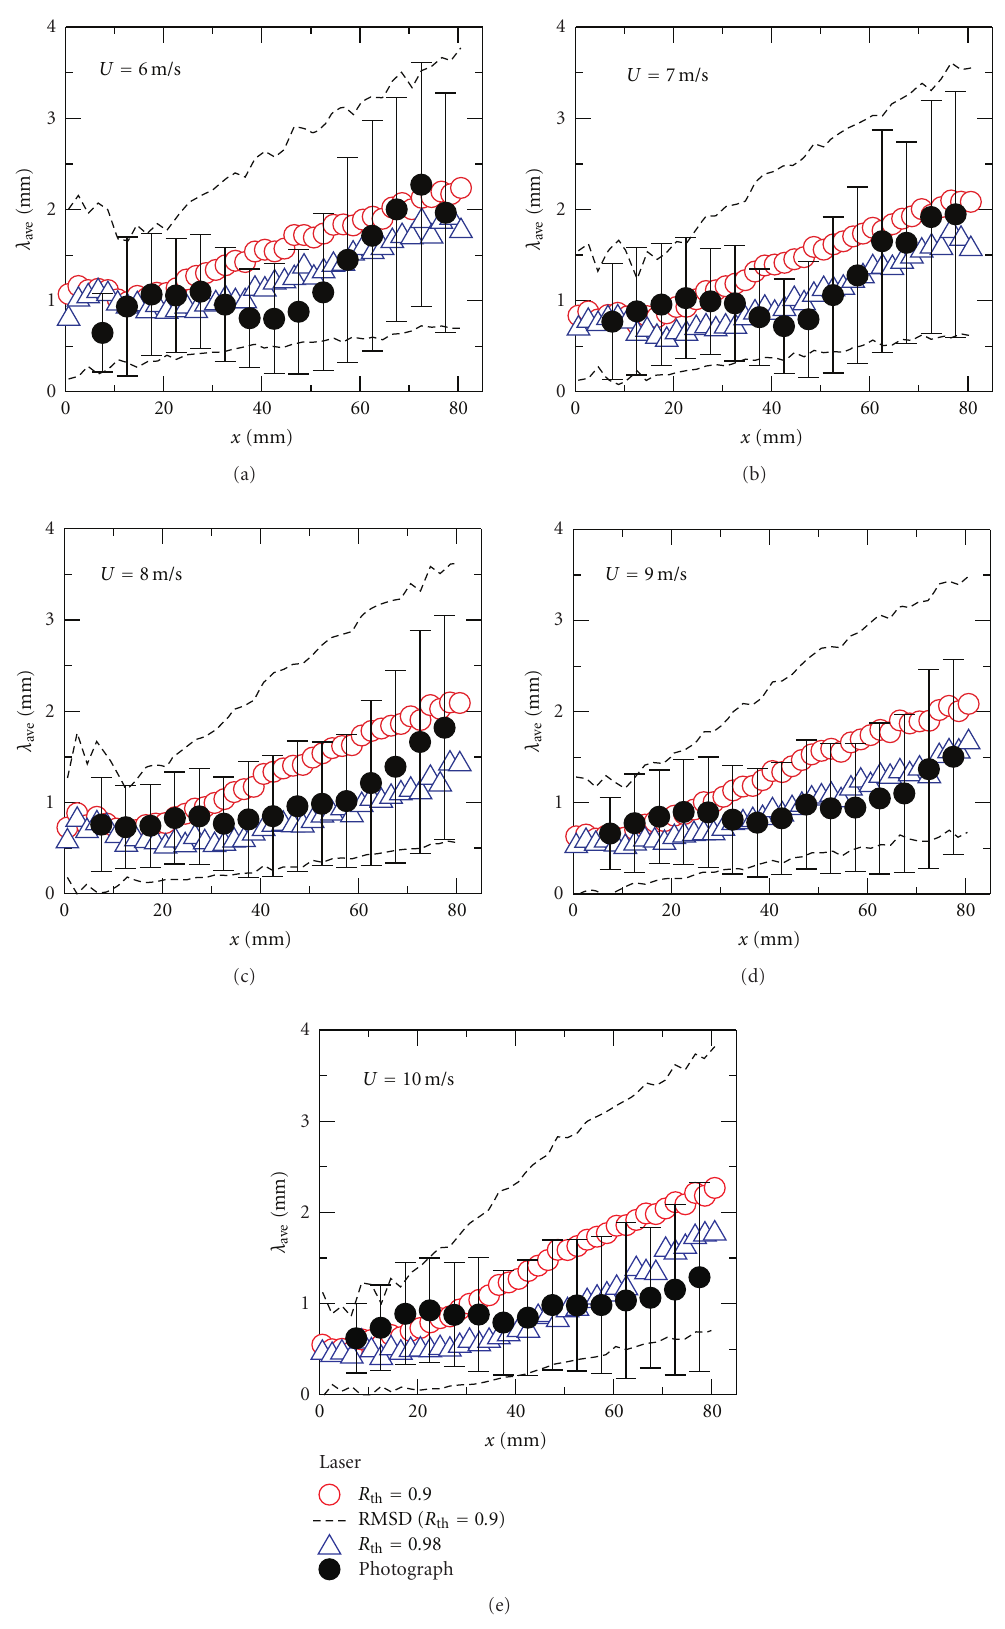
Figure 9: Local value of mean